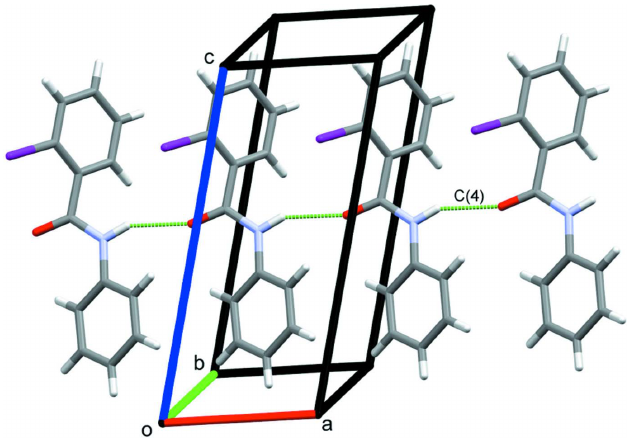
Figure 5 N—H (cid:2)(cid:2)(cid:2) O hydrogen bonds forming chains of molecules of (II) along the a -axis direction.